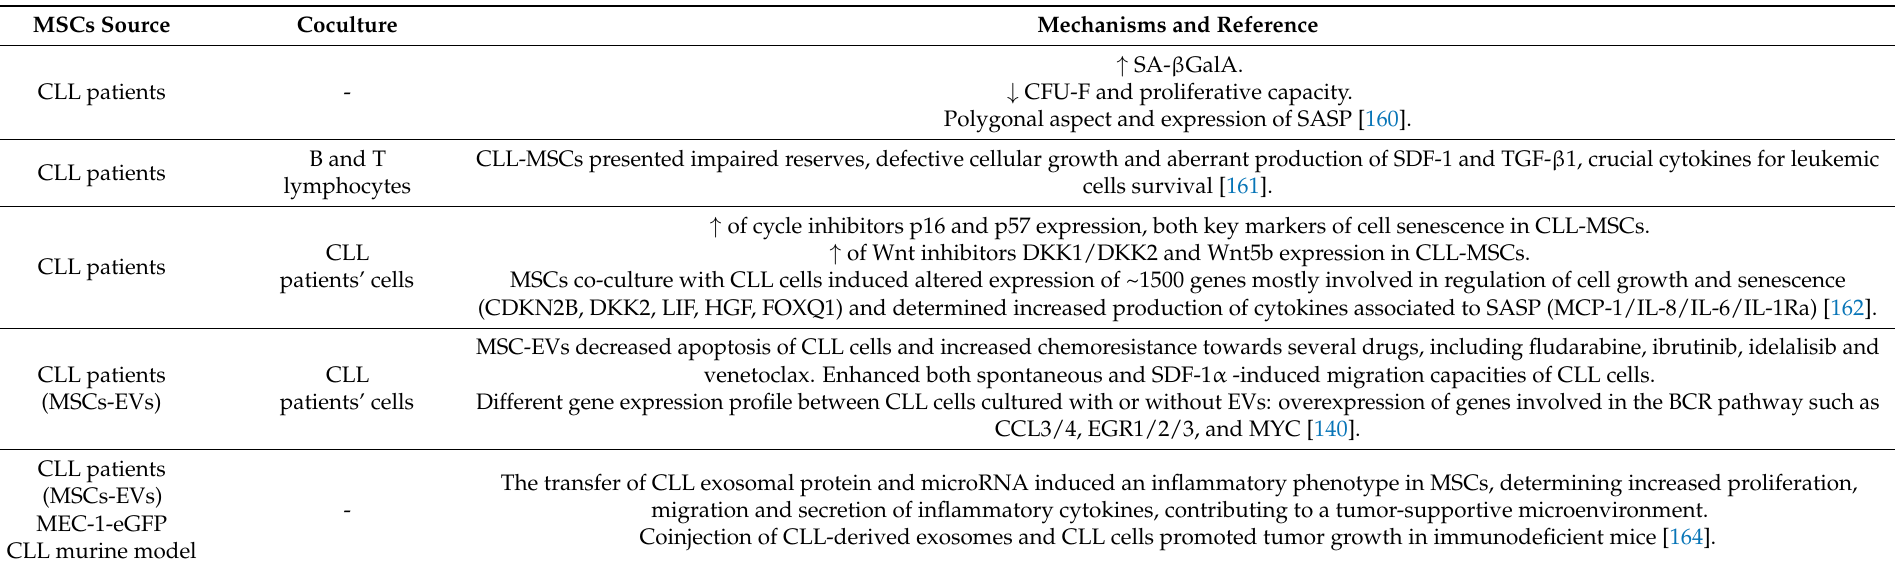
Table 2. Studies evaluating the activity of MSCs in CLL setting, with focus on MSCs senescence-like